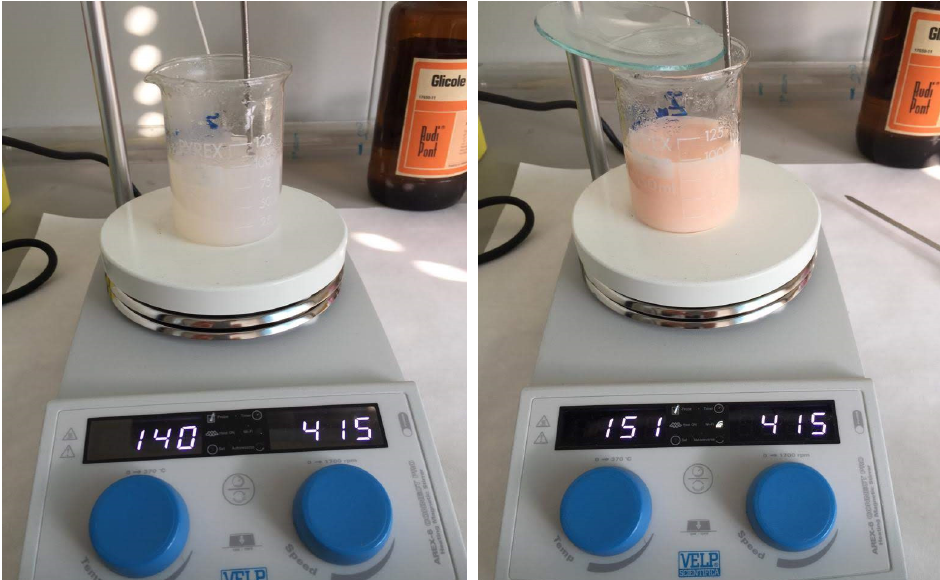
Figure 2. The color of the solution changes with temperature from milky white at 140 °C to rose pink at 150 °C. This change was very quick and easily detectable.